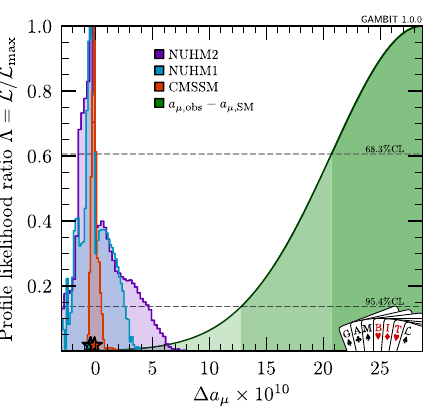
Fig. 11 1D profile likelihood ratio for (cid:11) a μ in the CMSSM (red), NUHM1 (blue) and NUHM2 (purple). For comparison we show a Gaussian likelihood for the observed discrepancy a μ, obs − a μ, SM = ( 28 . 7 ± 8 . 0 ) × 10 − 10 (green), adding the experimental and theoretical uncertanties in quadrature